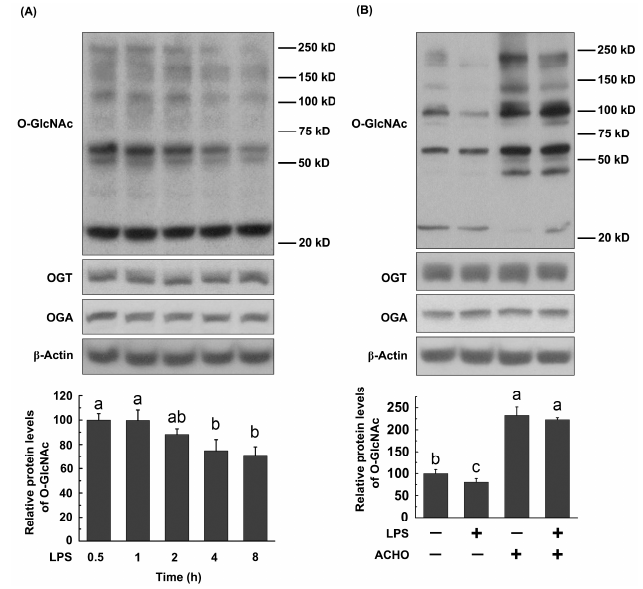
Figure 4. Effects of LPS and ACHO on protein O -GlcNAcylation in macrophage cells. ( A ) RAW264.7 cells were treated with LPS (200 ng/mL) for 0–8 h; ( B ) RAW264.7 cells were pretreated with ACHO (100 μ g/mL) for 12 h and then exposed to LPS (200 ng/mL) for 8 h. After that, cells were collected and analyzed by western blot. Data are represented as the mean ± SD ( n = 3). Data with different superscript letters are significantly different ( p < 0.05).